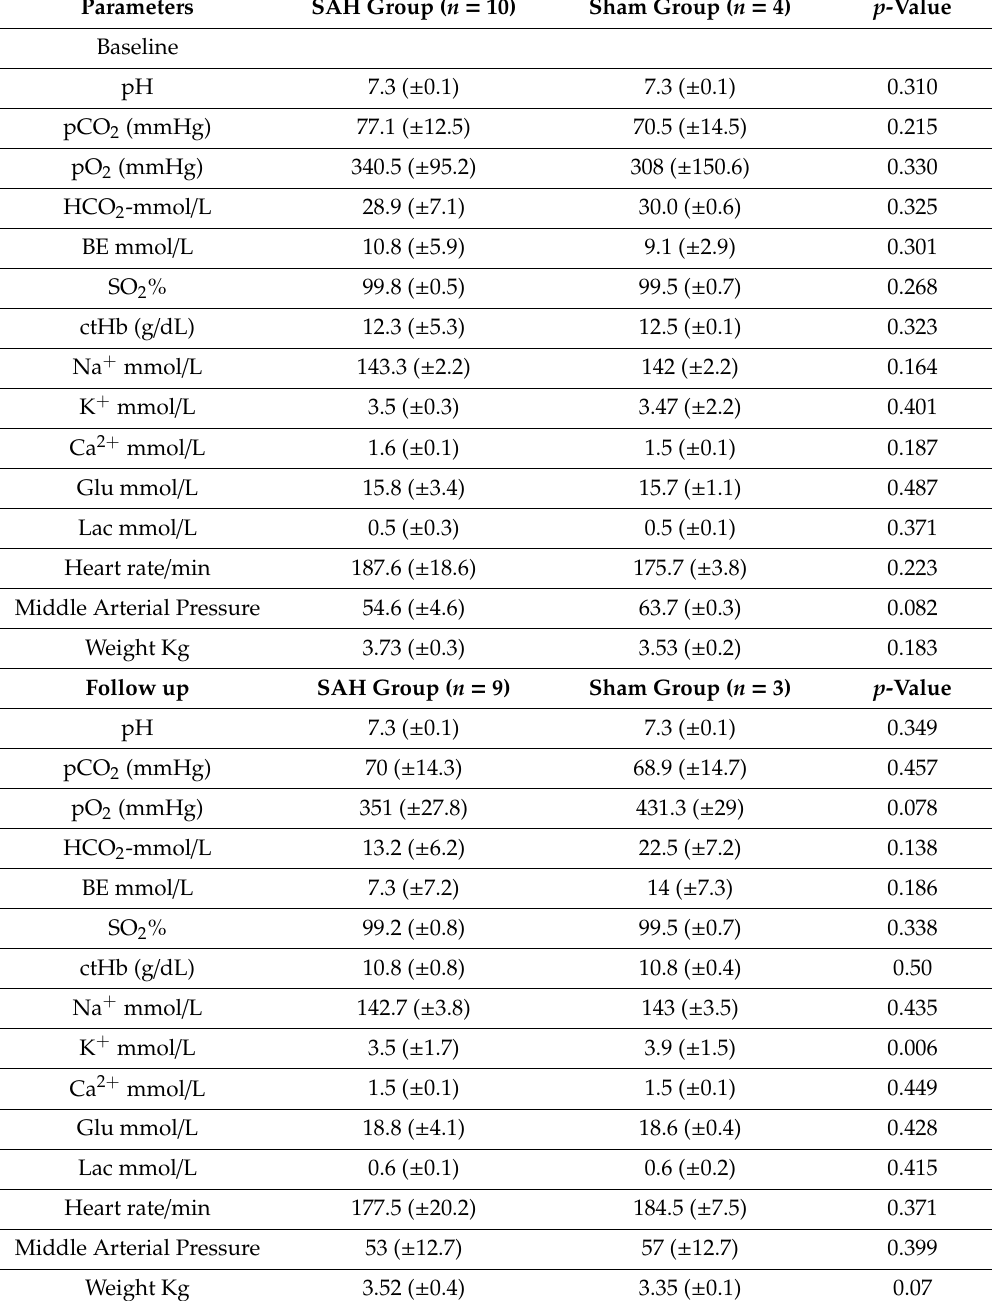
Table 1. Baseline and follow-up analyses for the subarachnoid hemorrhage (SAH) and sham